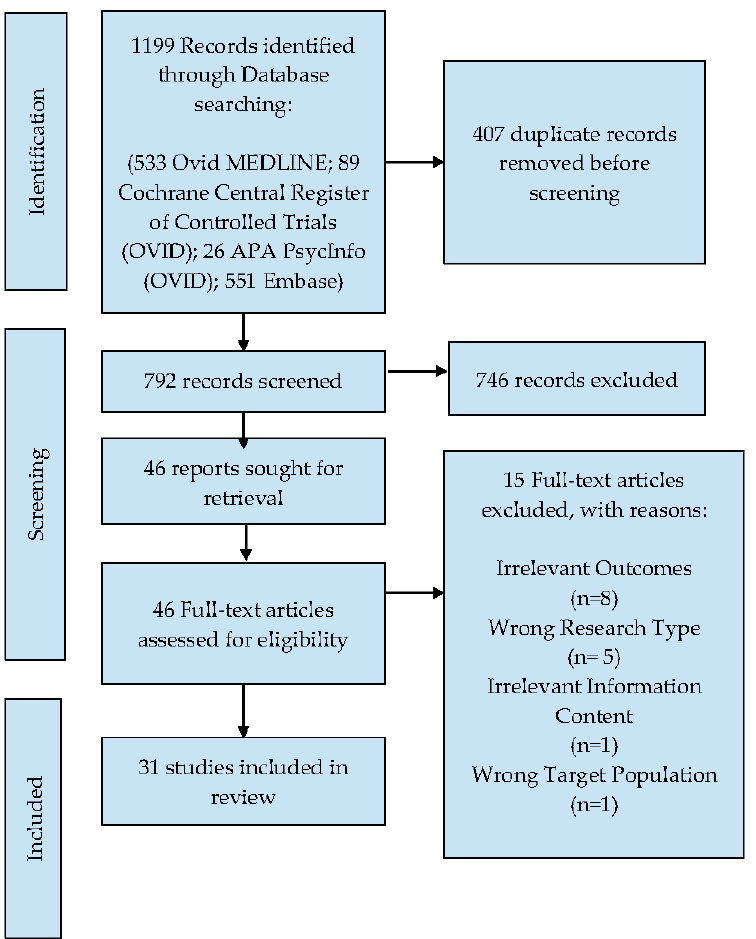
Figure 1. The preferred reporting items for systematic reviews and meta-analyses (PRISMA) study flow diagram.